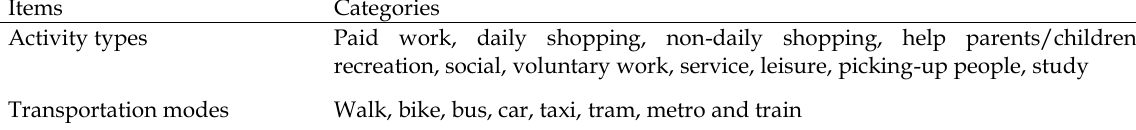
Table 1. Categories of activity types and transportation modes